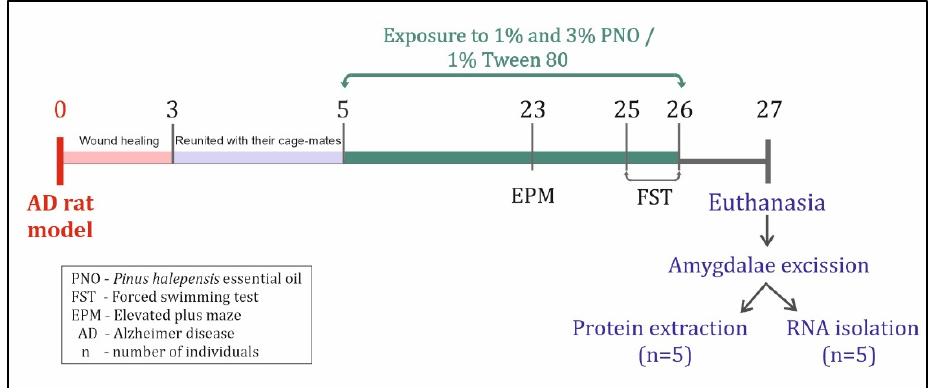
Figure 1. The experimental timeline. Drug administration, behavioral assessments, and tissue collection. AD, Alzheimer’s disease; EPM, elevated plus maze test; FST, forced swimming test; PNO, Pinus halepensis essential